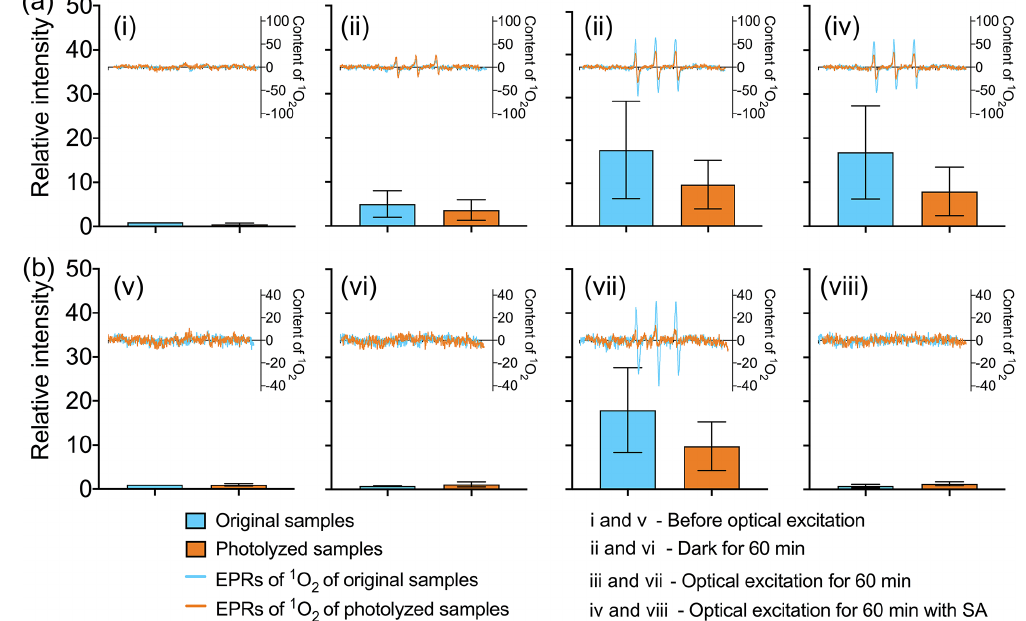
Figure 5. Changes in COM generating 1 O 2 before and after photodegradation: (a) POA and (b) ambient